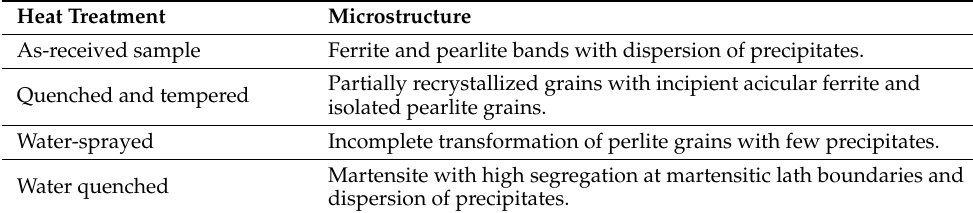
Table 6. Different microstructures of the X80 pipeline carbon steel. Data from [41]. Heat